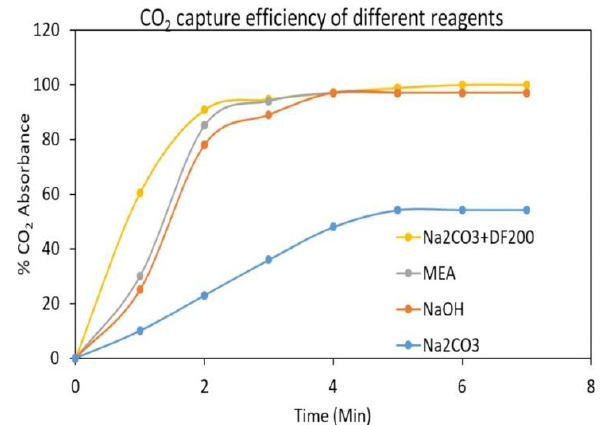
Figure 14. Comparison of CO 2 absorption efficiency of different sorbents, with the permission of [142].